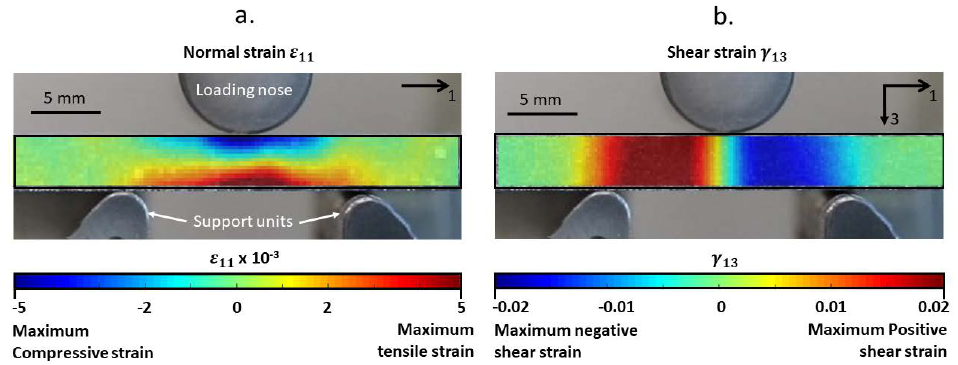
Figure 5. The strain distribution in the VHCF specimen under monotonic three − point bending load just before failure was calculated using DIC: ( a ) normal strain and ( b ) shear strain. These specimens failed at a loading force of 7330 ± 63 N, corresponding to a central deflection of 1103 ± 17 µ m. The final failure was the same for all the specimens and this was found to be due to the facture of the fibers in the bottom face of the specimen due to tension (see Figure 6a). This can also be seen in Figure 6b where the damage initiation at the bottom layer was followed by transverse damage propagation to the top side of the specimen. This also implies that the monotonic bending stresses are more critical than the monotonic shear stresses in the CF/PEKK material for the chosen specimen geometry.